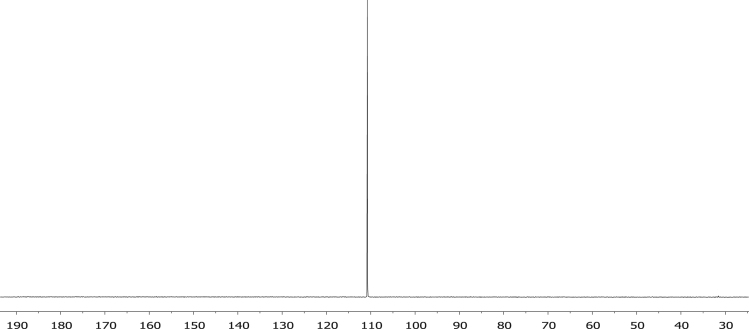
31P NMR of phenyl diphenylphosphinite, C6H5OPPh2, 1.